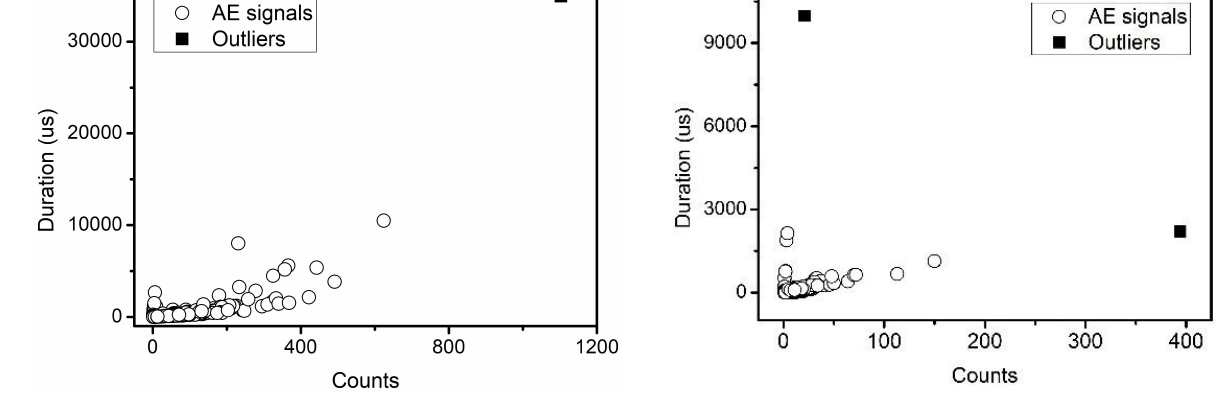
Figure 5: Noise identification for fiber bundle tensile test Figure 6: Noise identification for In-situ tensile